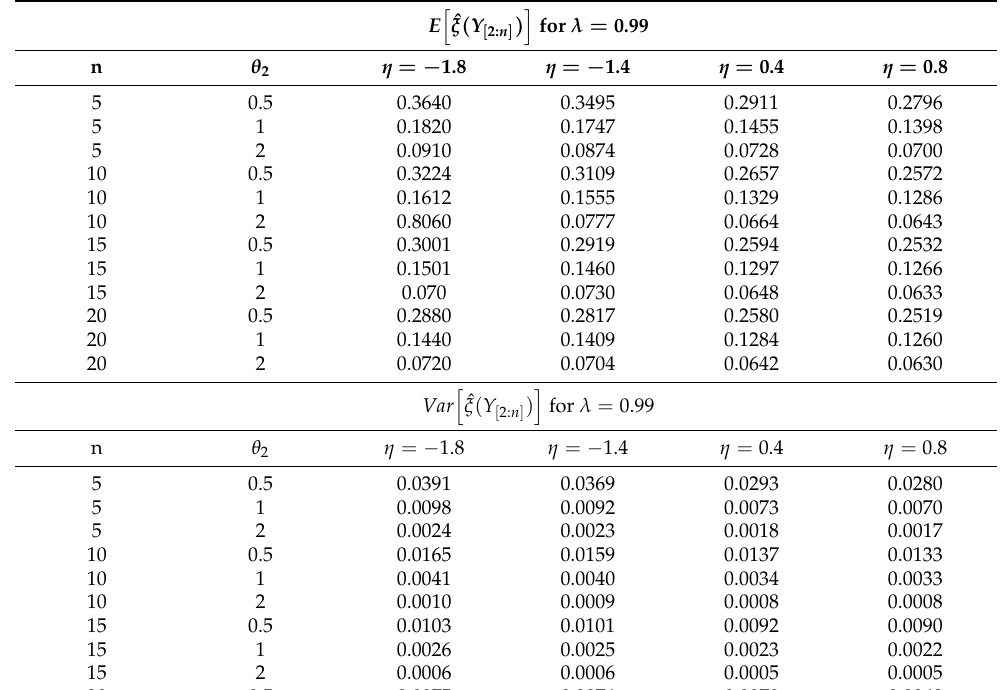
(cid:104) (cid:105) ˆ ξ ( Y ) from IFGM-ED. [ 2: n ]